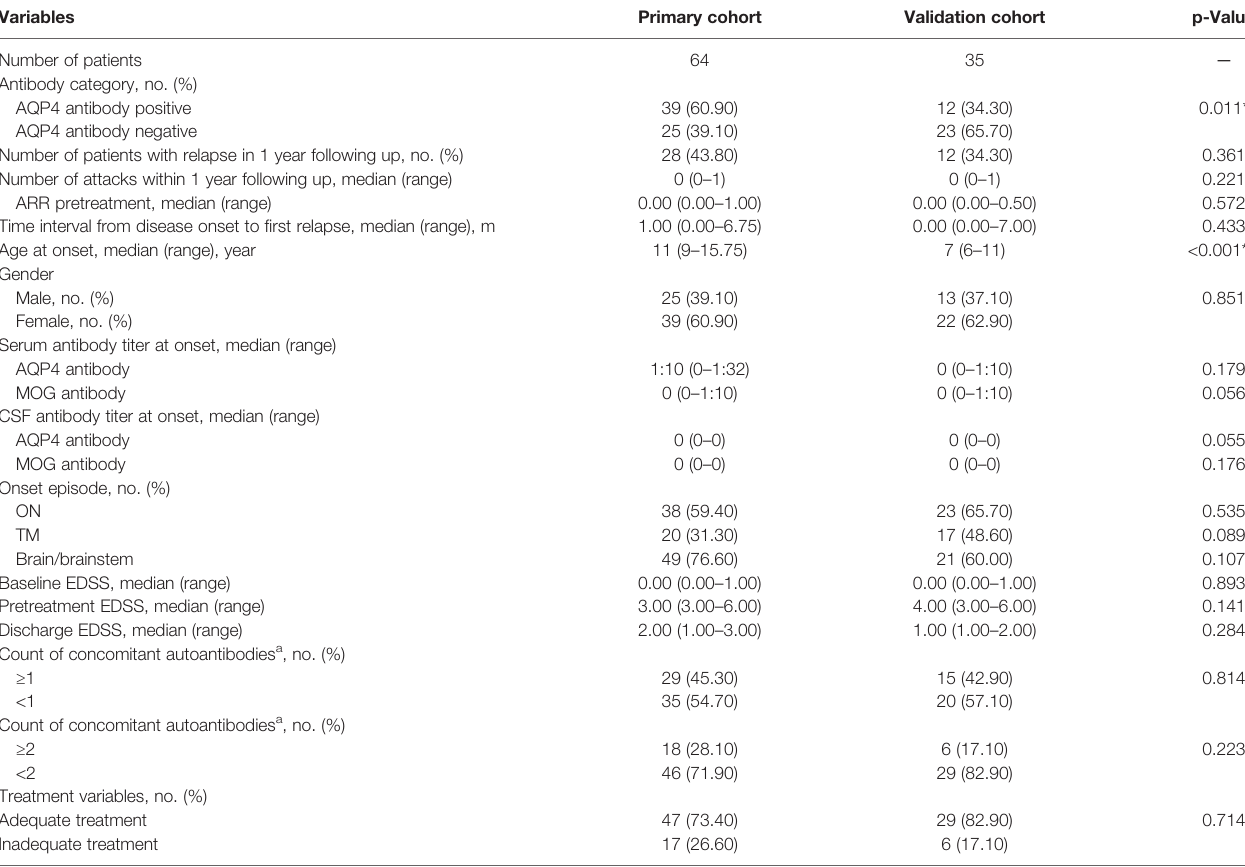
TABLE 3 | The demographics and clinical characteristics of pediatric patients in primary cohort and validation cohort.